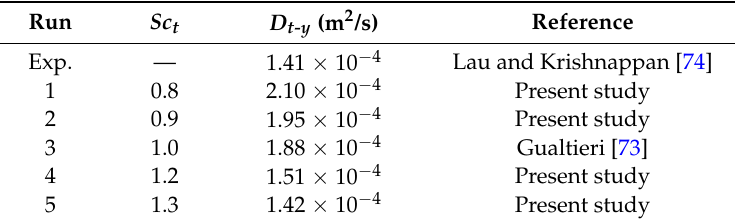
Table 4. Numerical simulations carried